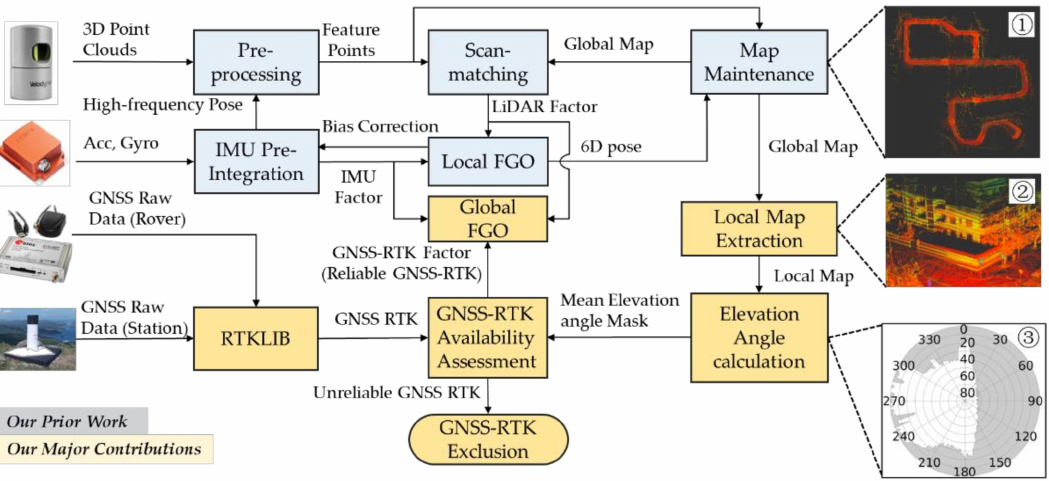
Figure 1. The framework of the proposed method that adaptively integrate GNSS-RTK [7] with LiDAR/IMU [33]. 1 (cid:13) denotes an example of the global point cloud map produced by LiDAR scan matching during local FGO. 2 (cid:13) denotes an example of the local map for mean elevation angle mask calculation. 3 (cid:13) demonstrates the mean elevation angle mask for GNSS-RTK availability assessment. The meaning of the annotation on the mask would be introduced in detail in Section